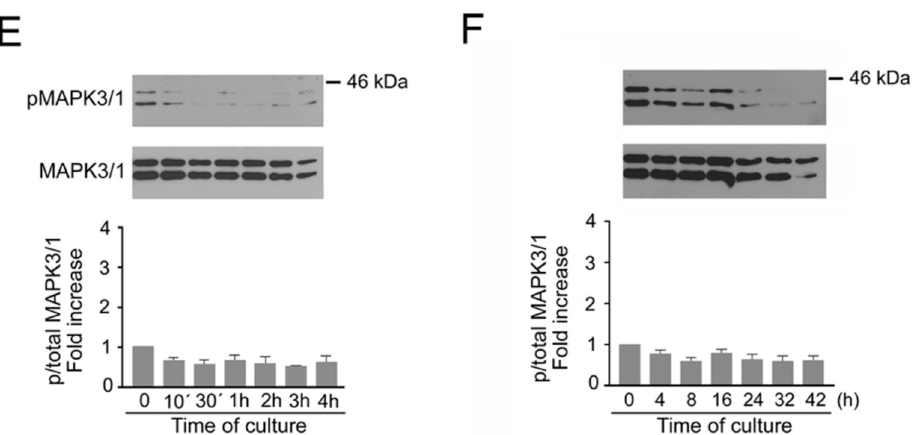
Figure 1. Time course of MAPK3/1 activation in cumulus-enclosed oocytes (COCs) stimulated with follicle-stimulating hormone (FSH) or amphiregulin (AREG). The panels show representative results of immunoblotting of phosphorylated and total MAPK3/1 in samples of 25 COCs cultured in vitro for the indicated periods of time. The experiments shown in panels A and B were repeated twice with the same results. The experiments shown in panels ( C – F ) were repeated three times. Quantification of the activated MAPK3/1 was performed by densitometry and is shown in the graphs as proportions of phosphorylated and total MAPK3/1 and expressed in arbitrary units as the fold increase over the proportion found in unstimulated COCs at the beginning of the culture. ( A ) Activation of MAPK3/1 in FSH-stimulated COCs during the long-term culture. ( B ) Activation of MAPK3/1 in AREG-stimulated COCs during the long-term culture. ( C ) Activation of MAPK3/1 in FSH-stimulated COCs during the short-term culture. ( D ) Activation of MAPK3/1 in AREG-stimulated COCs during the short-term culture. ( E ) Activity of MAPK3/1 in COCs cultured for short-term period in control medium without FSH and AREG. ( F ) Activity of MAPK3/1 in COCs cultured for long-term period in control medium without FSH and AREG. The different superscripts above the columns indicate significant differences ( p < 0.05).